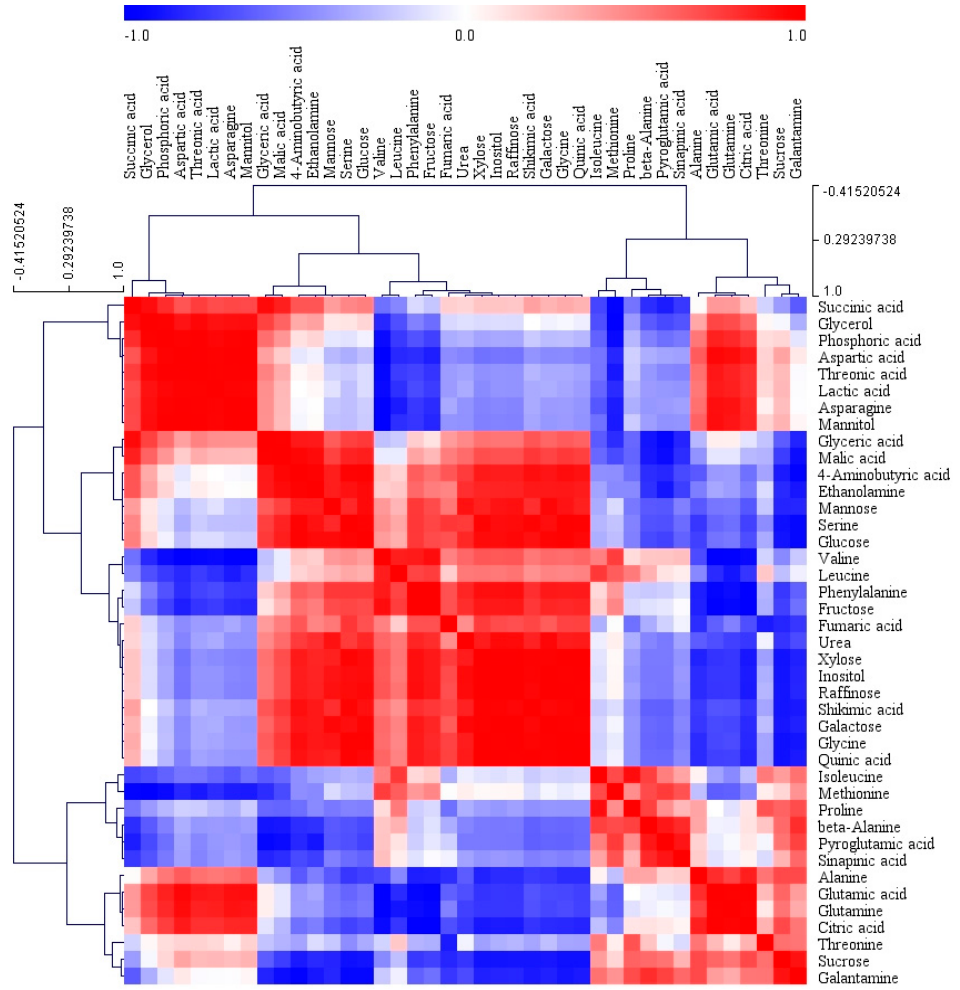
Figure 7. Correlation matrix and cluster analysis of results obtained from data on 41 metabolites for di ff erent organs of L. radiata grown in a growth chamber. Each square shows the Pearson’s correlation coe ffi cient for a pair of metabolites, and the value for the correlation coe ffi cient is represented by the intensity of the red or blue color as indicated on the color scale. Hierarchical clusters are represented by a cluster